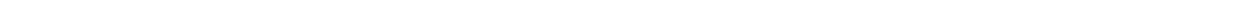
Fig. 4 Prioritizing genes and regulatory elements at the FADS1 / FADS2 locus for rheumatoid arthritis (RA) with a plausible regulation mechanism. a Results of SNP and SMR associations across mQTL, eQTL and GWAS. The top plot shows − log 10 ( P -values) of SNPs from the GWAS meta-analysis for RA 42 . The red diamonds and blue circles represent − log 10 ( P- values) from SMR tests for associations of gene expression and DNAm probes with RA, respectively. The solid diamonds and circles are the probes not rejected by the HEIDI test. The yellow star indicates the previously reported causal variant rs968567. The second plot shows − log 10 ( P -values) of the SNP association for gene expression probe ILMN_2075065 (tagging FADS2 ) from the CAGE eQTL study. The third plot shows − log 10 ( P -values) of the SNP associations for DNAm probe cg06781209 from the mQTL study. The bottom plot shows 14 chromatin state annotations (indicated by colours) of 127 samples from REMC for different primary cells and tissue types (rows). b A hypothetical regulation mechanism. When the DNAm site in the promoter is unmethylated, the transcription factor SREBF2 (activator) binds to the promoter and enhances the transcription of the FADS2 gene. When the DNAm site is methylated (by the effect of the genetic variant rs968567 at the promoter), the binding of SREBF2 is disrupted and therefore the transcription of FADS2 is